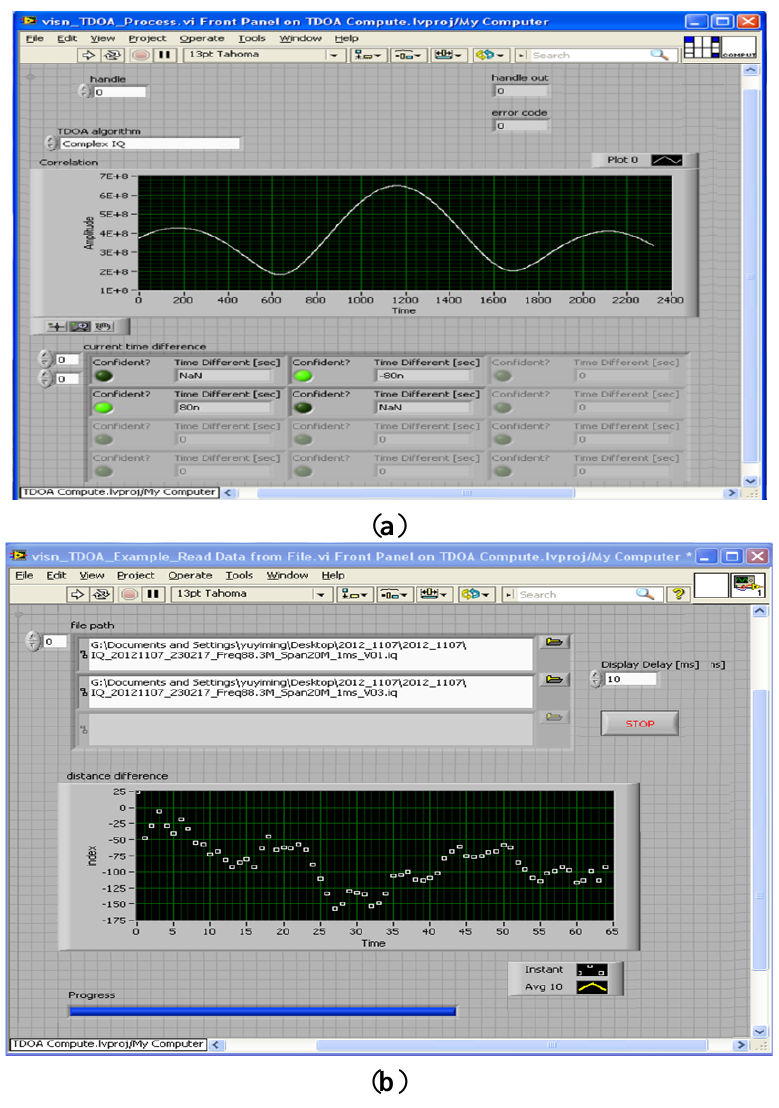
Figure 6. The 88.3 MHz experimental evaluation of ( a ) time difference and ( b ) distance difference using cross-correlation algorithm in TDOA-based monitoring/locating